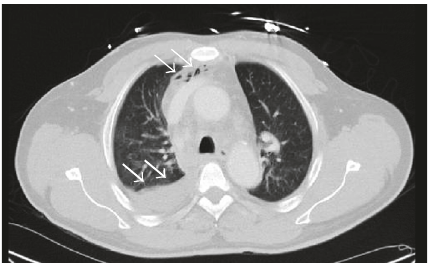
Figure 2: CT chest without contrast showed pneumomediastinum at the right superior mediastinum as shown by the white nar- row arrow. The white thick arrow shows moderate right pleural effusion with 80 Hounsfield units suggestive of internal hemor- rhage/proteinaceous